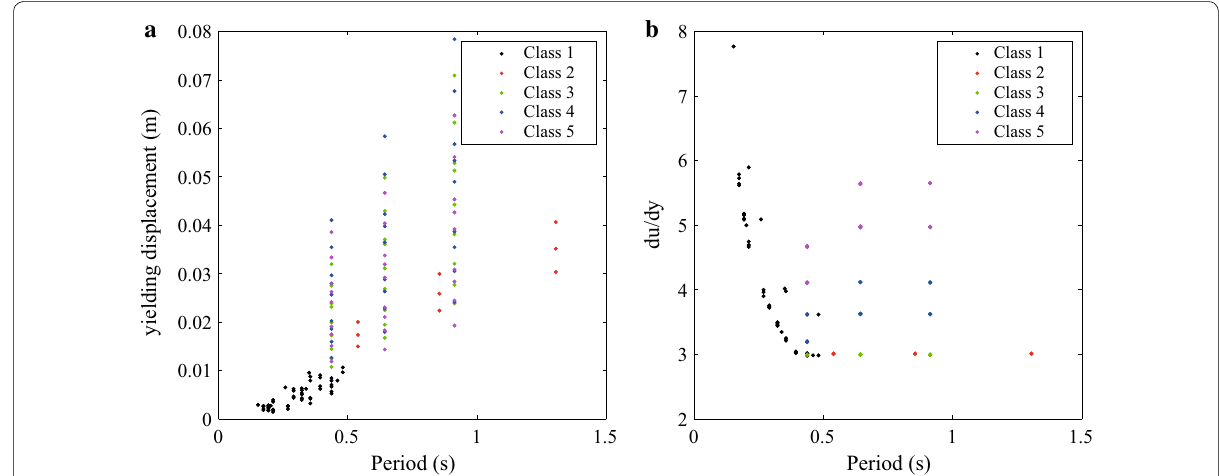
Fig. 1 Distribution of the mechanical parameters of the 141 building structures as a function of their fundamental period (s): a yielding displace‑ ment d y (m); b ductility ratio d u / d y . The color code corresponds to five different typology classes [taken from Lagomarsino and Giovinazzi